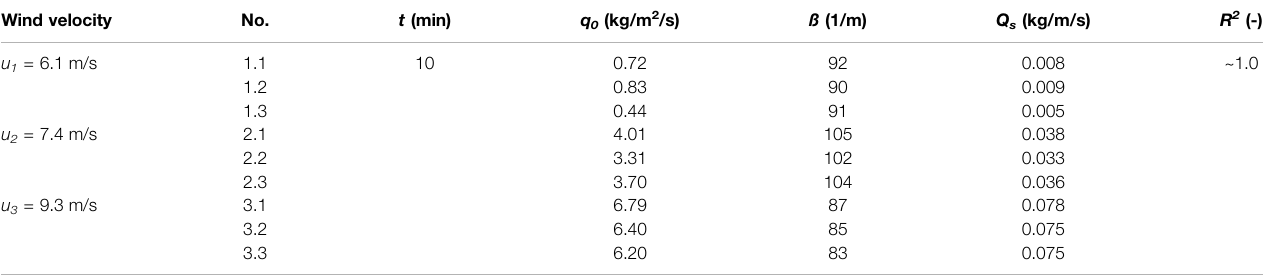
TABLE 1 | Total mass fl ux results over the measuring duration, decay rate, extrapolated saltating sediment mass transport at the surface, and correlation coef fi cients of the vertical sediment pro fi le regression analysis. Wind